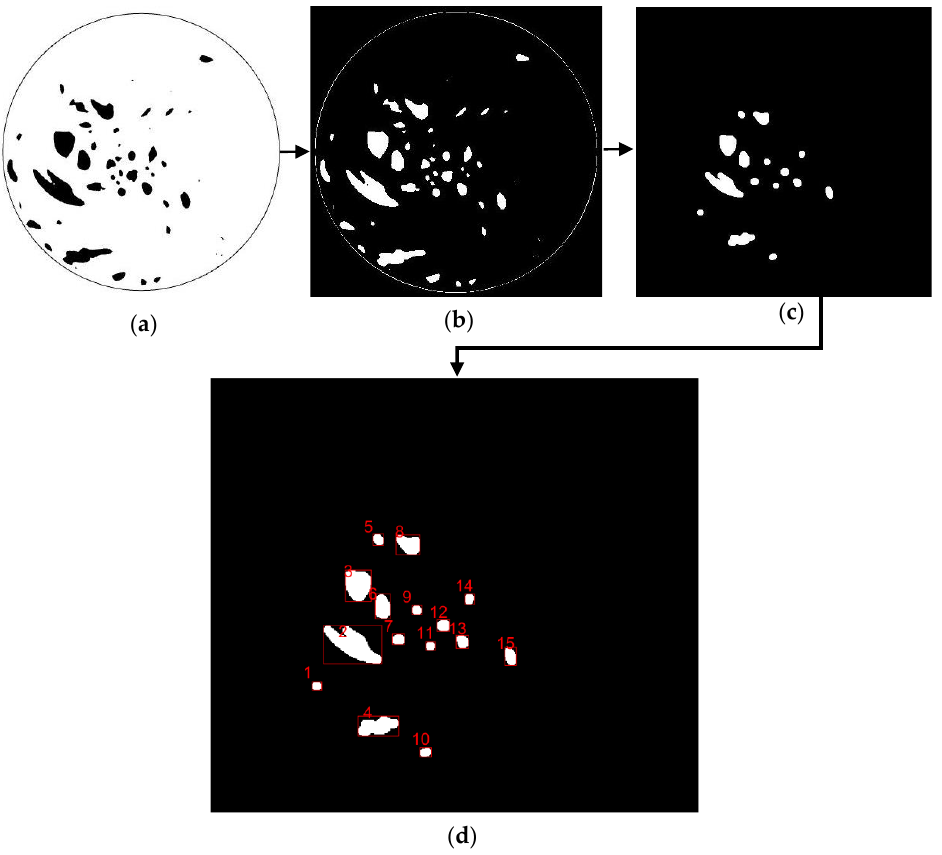
Figure 7. Schematic diagram of different sections of vortex rope in draft tube.